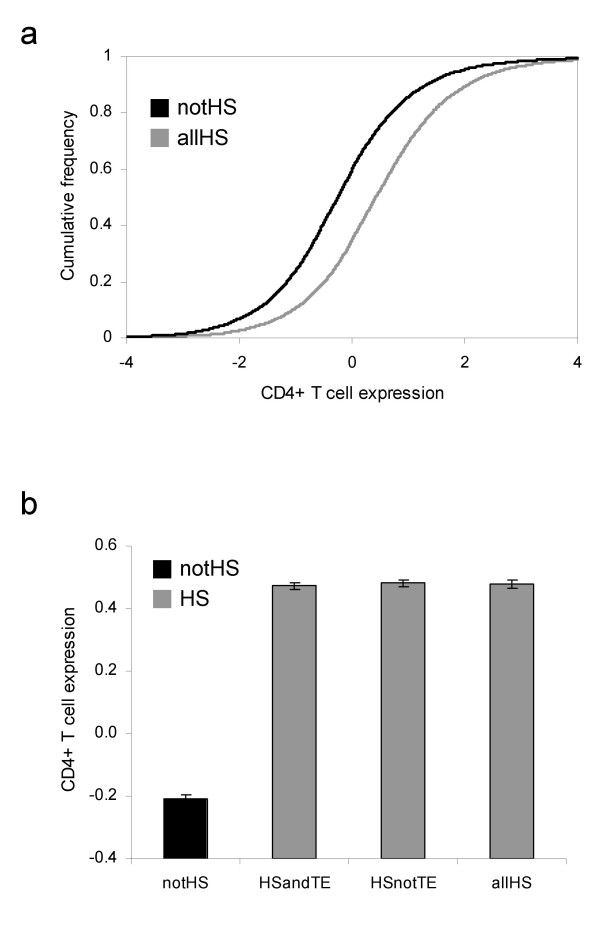
Comparison of CD4+ T cell expression levels for different classes of human genes. a) Cumulative frequency distributions of CD4+ T cell expression for genes do not have any HS sites (notHS) and genes with HS sites (allHS). b) Comparison of average CD4+ T cell expression levels for without (notHS) and with (allHS) HS sites. Genes with HS sites were further broken down into groups of genes with TE-derived (HSandTE) and not TE-derived (HSnotTE) HS sites.